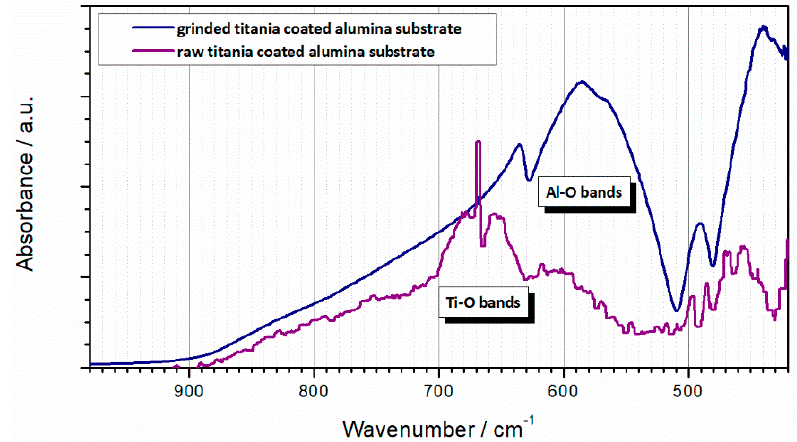
Figure 7. Attenuated total reflectance (ATR) FTIR scans of TiO 2 -coated Al 2 O 3 foam: raw porous substrate sample (purple line) and ground powdered sample (blue line).